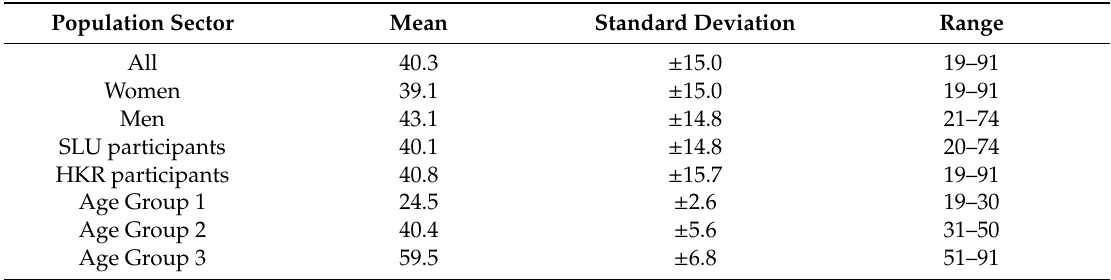
Table 2. Demographical distribution of the study population. Age in years.